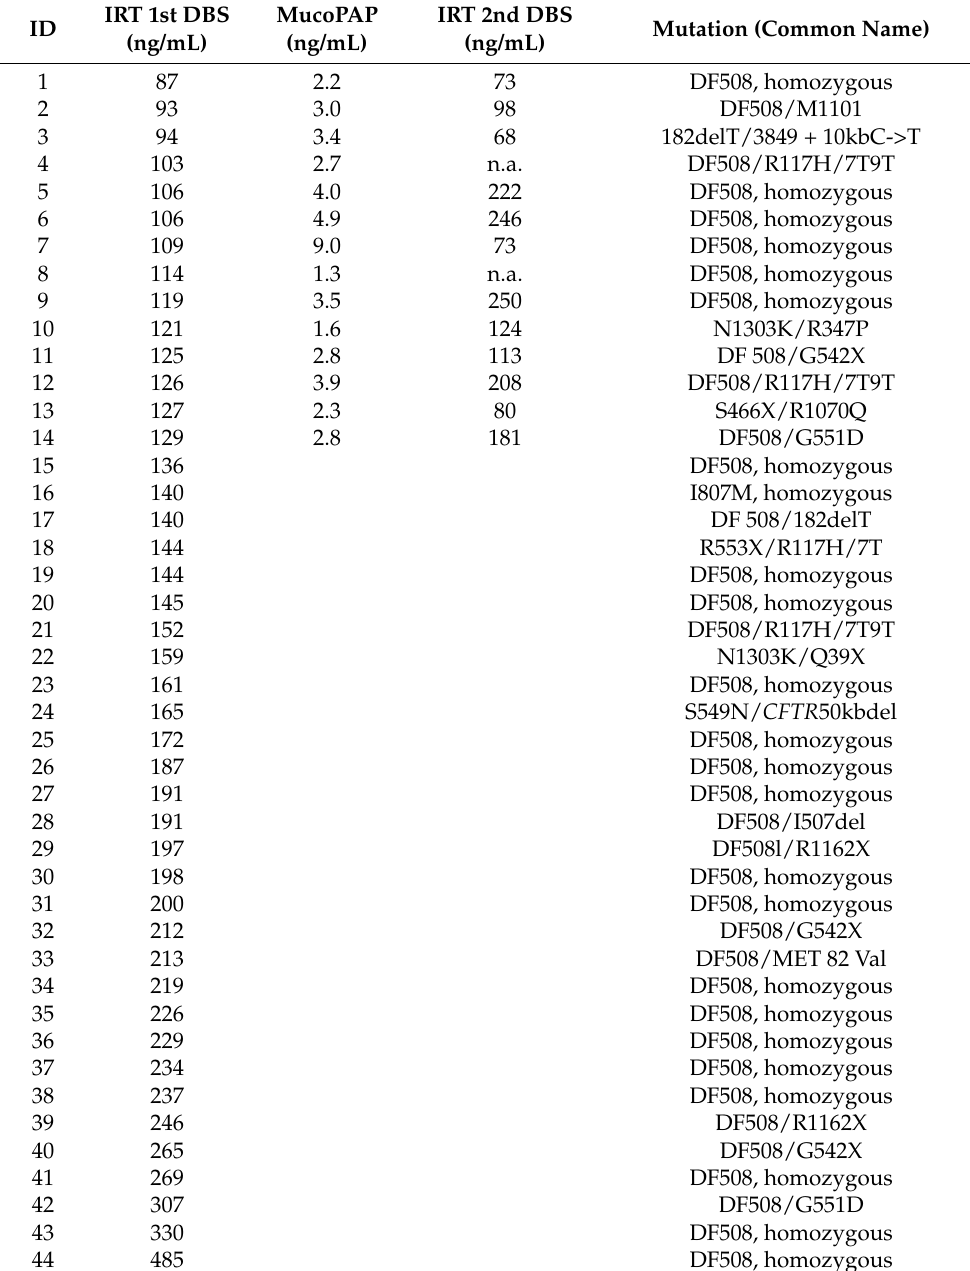
Table 1. Newborn screening and genetic testing results of CF cases detected by the Austrian newborn screening within the overall observation period, sorted by initial